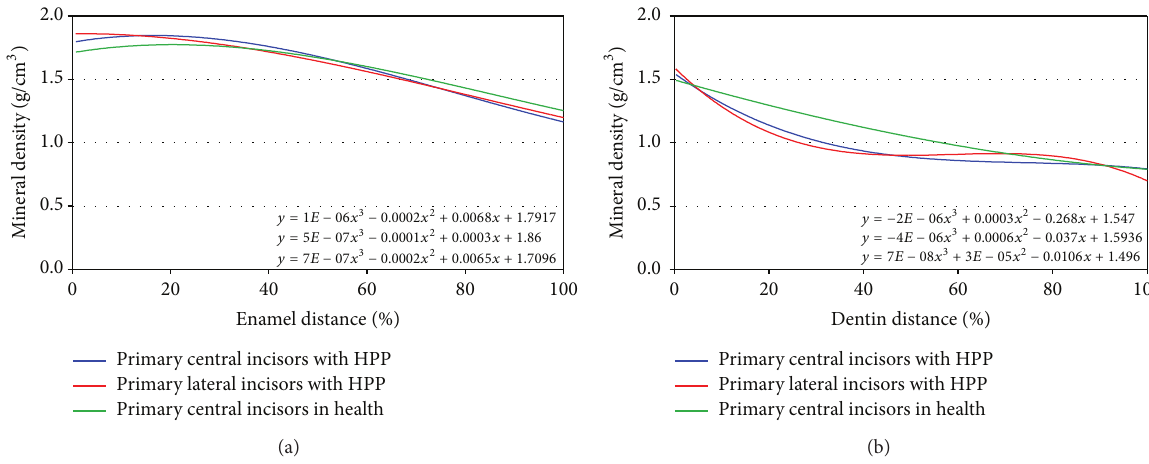
Figure 4: Mineral density distribution in (a) enamel and (b) dentin. The cubic regression curves were obtained using the least squares